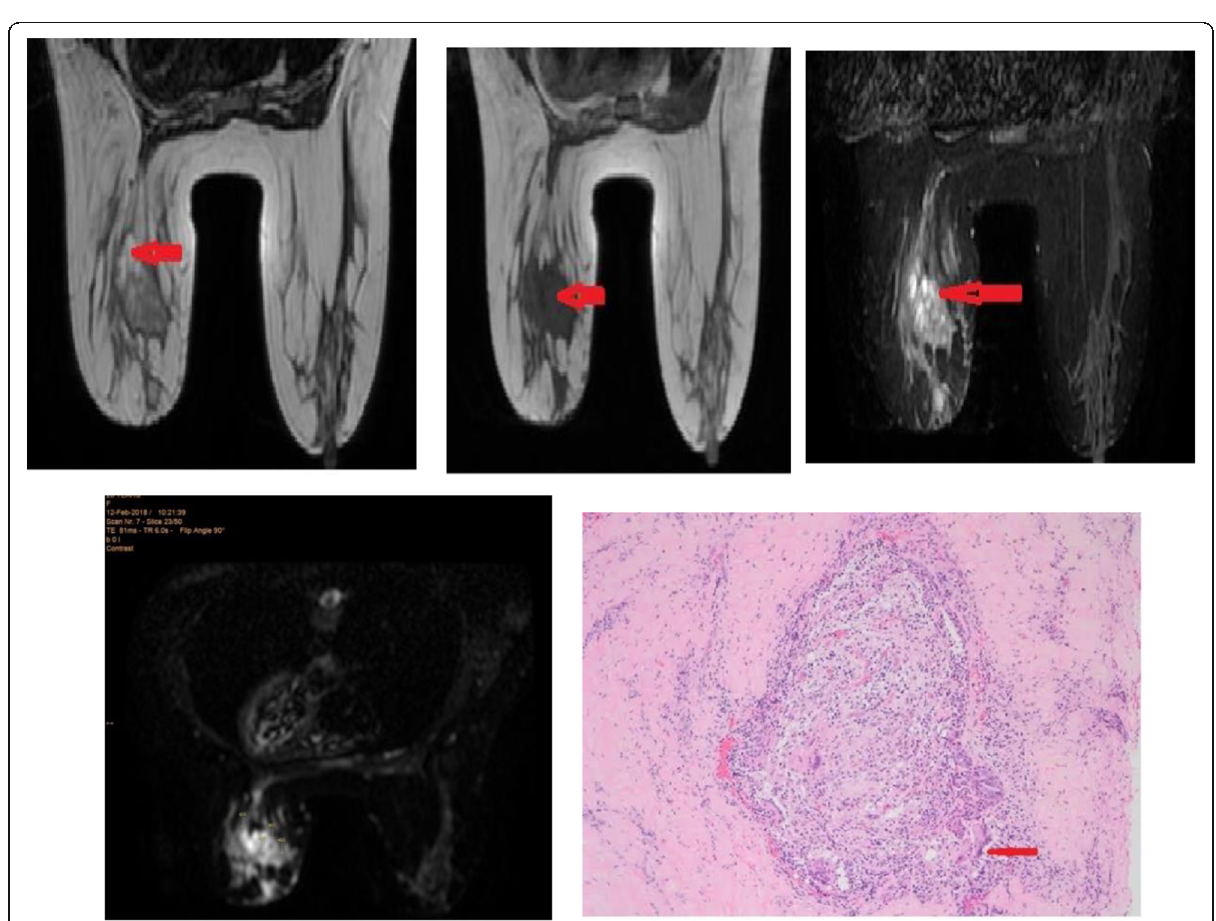
Fig. 3 28-year-old female patient with negative family history presented with left retroareolar lump. The mass shows intermediate signal on T2, low signal on T1, and heterogeneous bright signal on STIR. The solid parts of the mass show restricted diffusion and ADC values range from 1.1 to 1.2 × 10 − 3 mm 2 s. The pathological diagnosis is inflammatory lesion, negative for malignancy